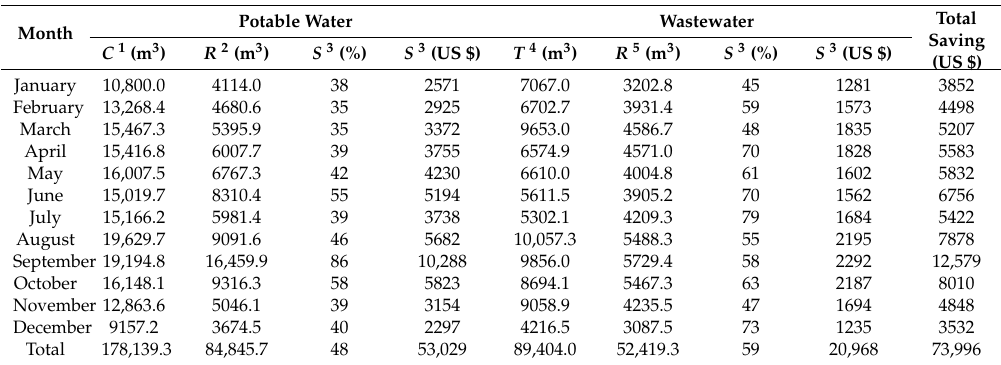
Table 9. Economic benefits expected to be obtained after implementing the systems for rainwater harvesting and greywater treatment and reuse on Monterrey Campus. Potable Water Wastewater Total Month